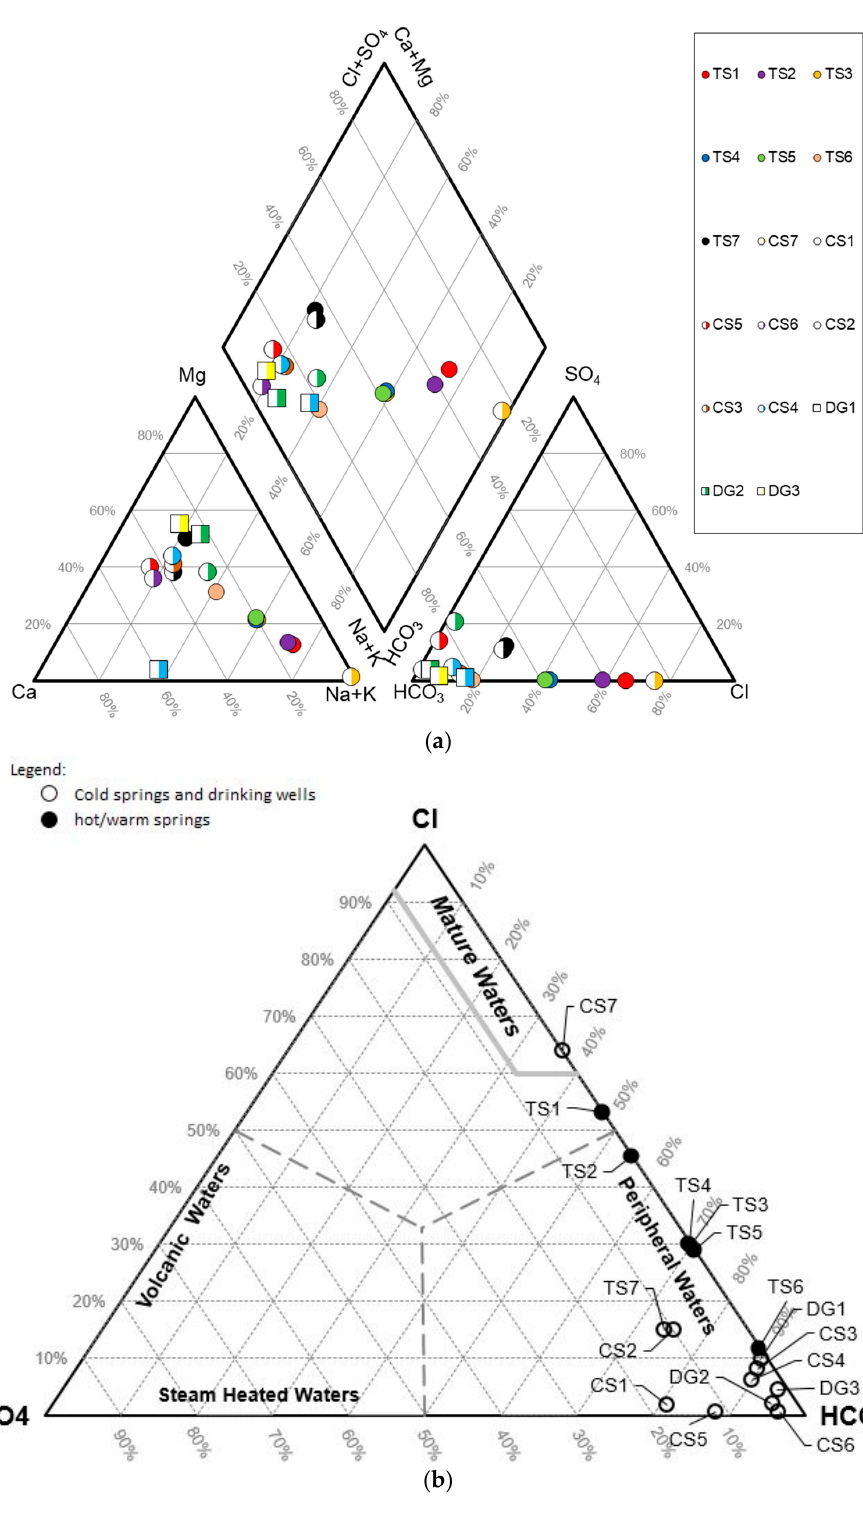
Figure 7. ( a ) Data plot of thermal springs, cold springs and dug wells in a Piper diagram. Cold spring and dug well data are distributed at the same cluster. The Ca/Mg–HCO 3 type is an indicator of meteoric water product, while thermal waters show enrichment patterns toward anion and cation elements, i.e., Na–K and Cl. ( b ) Data plot of thermal springs, cold springs and dug wells into anion Cl–SO 4 –HCO 3 ternary diagrams. There is only one cold spring (CS7) that belongs to chloride water, while all the thermal springs are Cl–HCO 3 , and cold springs are HCO 3 -type waters.